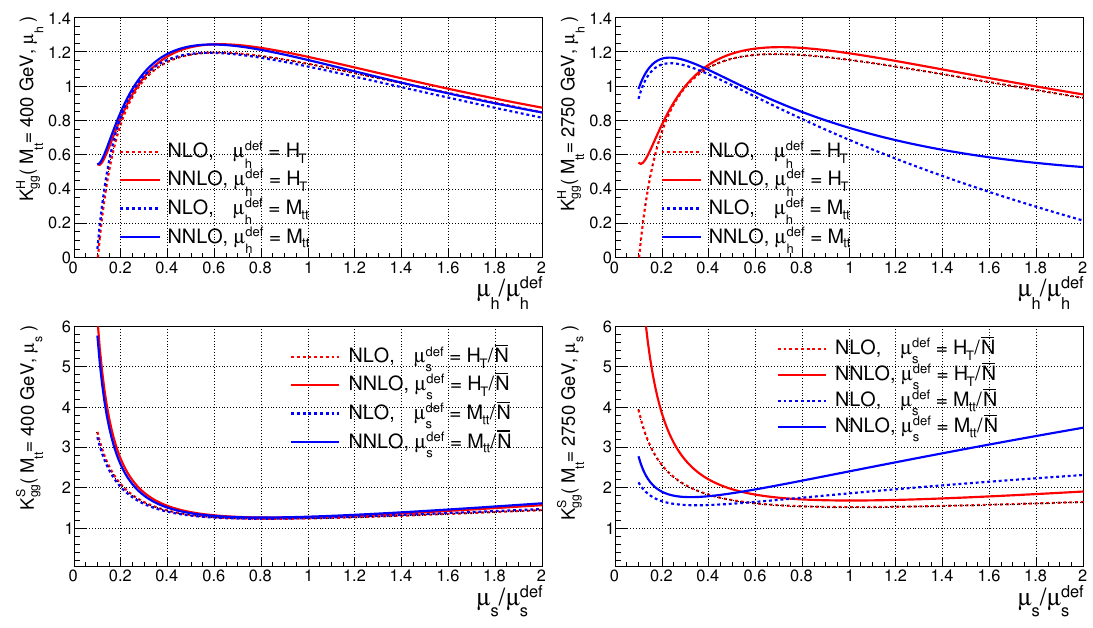
Figure 2 . The K factors for the corrections to the hard (top) and soft (bottom) functions in the gg channel as de(cid:12)ned in the text, at M t (cid:22) t = 400 GeV (left) and M t (cid:22) t = 2750 GeV (right).